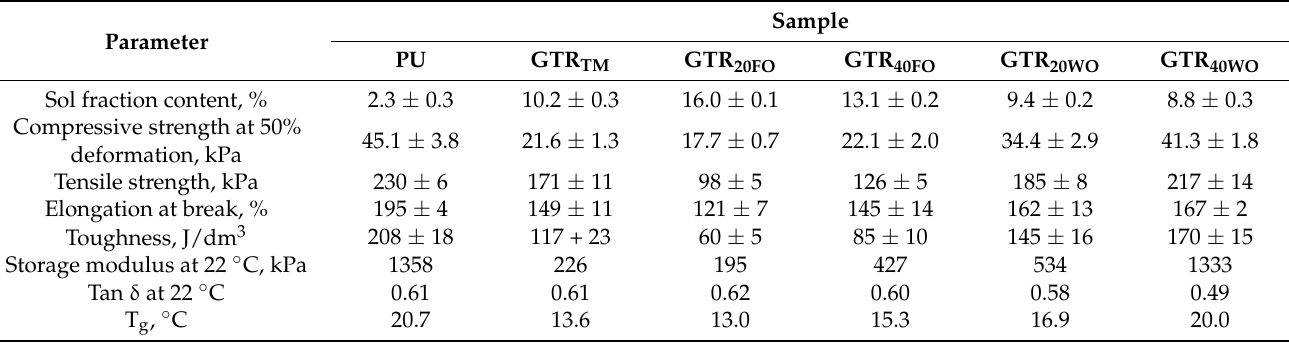
Table 5. The physico-mechanical properties of prepared